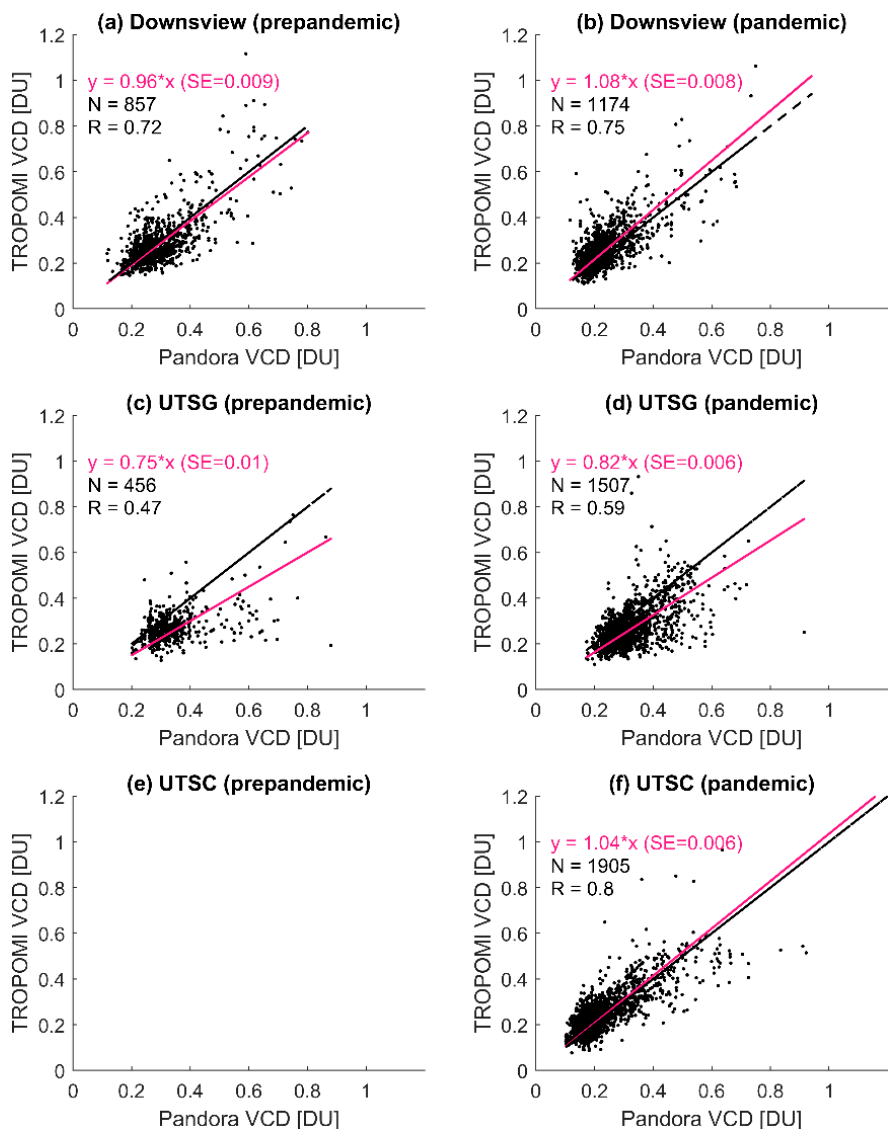
Figure A5. TROPOMI (S5P-PAL standard product) vs. Pandora NO 2 total column (VCD) measurements at Downsview, UTSG, and UTSC, using data from before the pandemic ( a , c , e ) and since pandemic ( b , d , f ). The magenta line is the linear fit with intercept set to 0, and the black line is the one-to-one line. Pandora measurements taken within ±1 h around the TROPOMI overpass time were used (observations from 15 March to 15 September for each year).